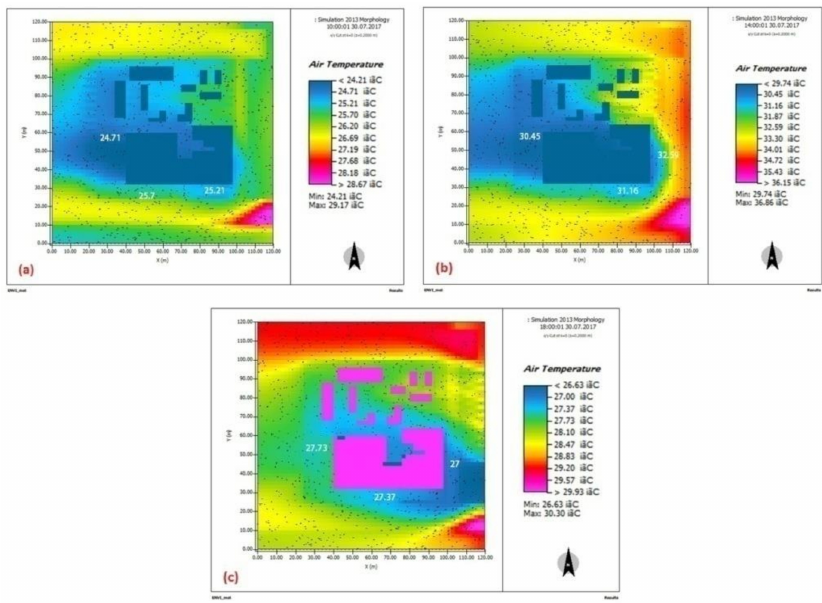
Figure 9. ENVI-met simulation outputs for T air at ( a ) 10:00; ( b ) 14:00; and ( c )